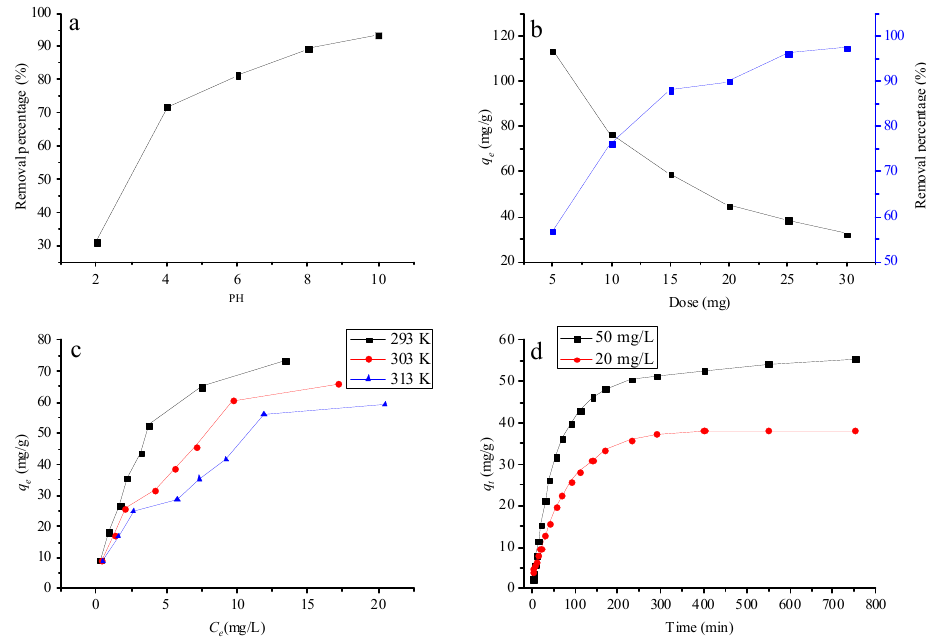
Figure 5. Effect of different factors on MB adsorbed by PGO-4 aerogel: ( a ) pH effect, ( b ) dose effect, ( c ) temperature effect, and ( d ) contact time effect.